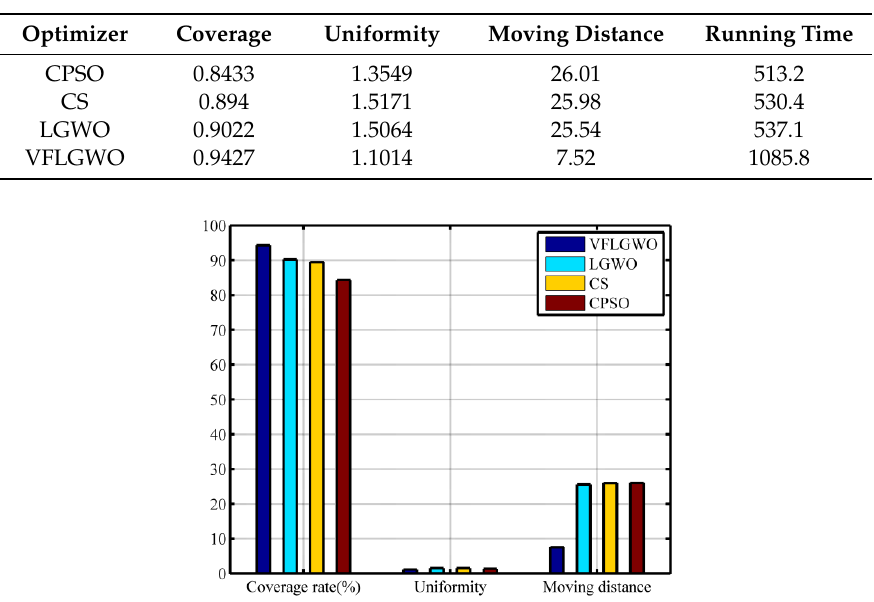
Table 5. Indicators of the CPSO, CS, LGWO and VFLGWO algorithms for 3000 generations.